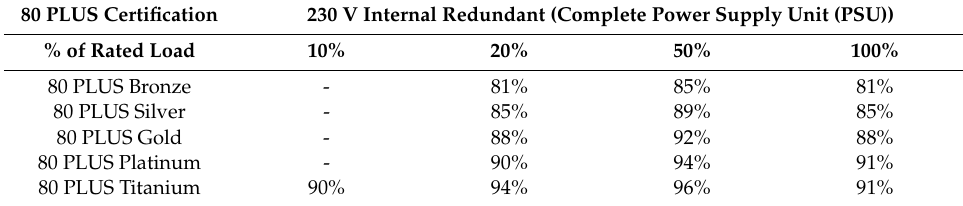
Table 1. Summary of e ffi ciency requirements of 80 PLUS certification for redundant power